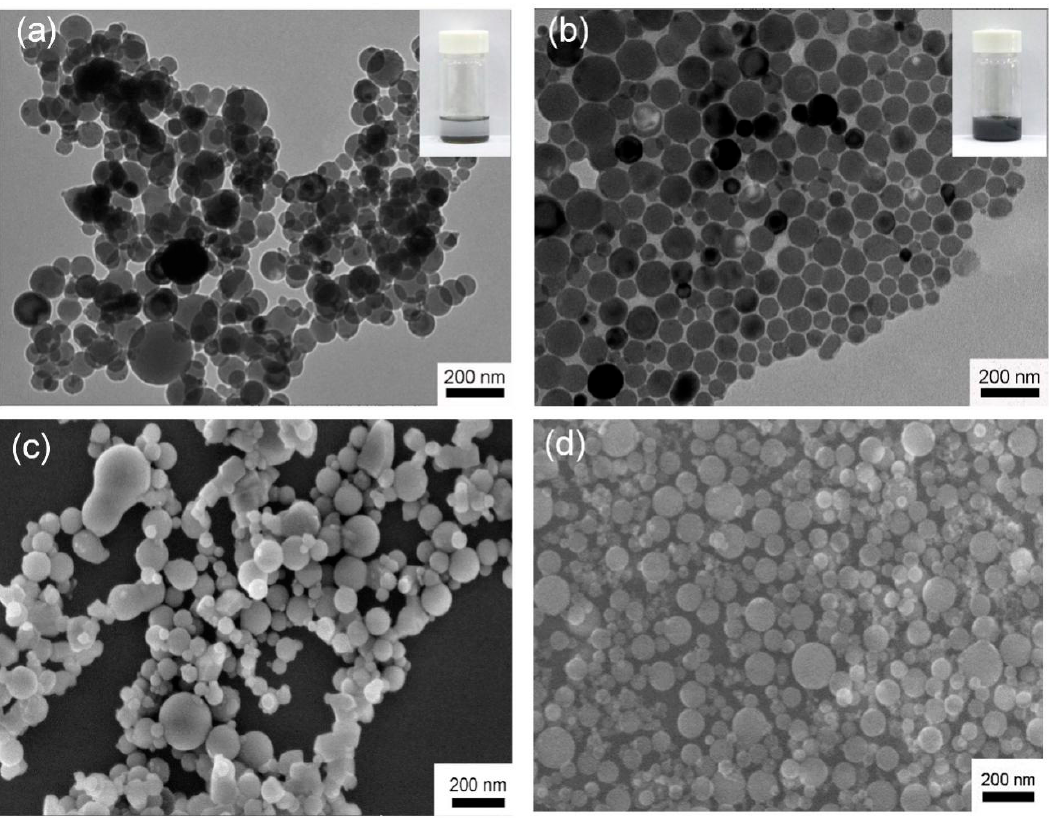
Figure 1. TEM ( a ) and SEM ( b ) images of aggregated Al NPs prepared by EEW method and TEM ( c ) and SEM ( d ) isolated Al NPs after grafting with polystyrene with –COOH end-group, respectively.